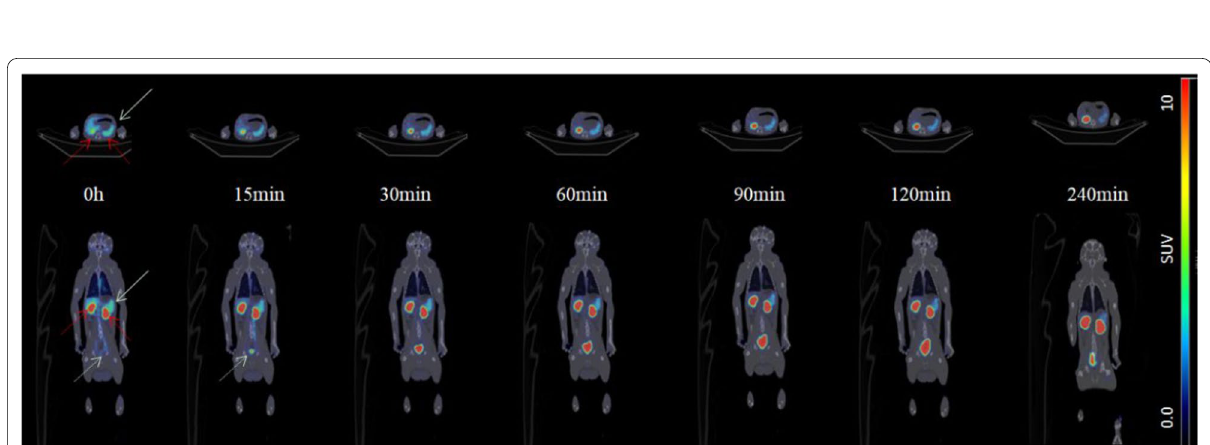
Fig. 4 Representative PET/CT images of a healthy cynomolgus monkey at different time intervals after injecting 68 Ga-NOTA-Nb109. Below: coronal tomograms; above: transverse tomograms. The white arrow indicates the spleen, the white dotted line indicates the bladder, and the red dotted line indicates the